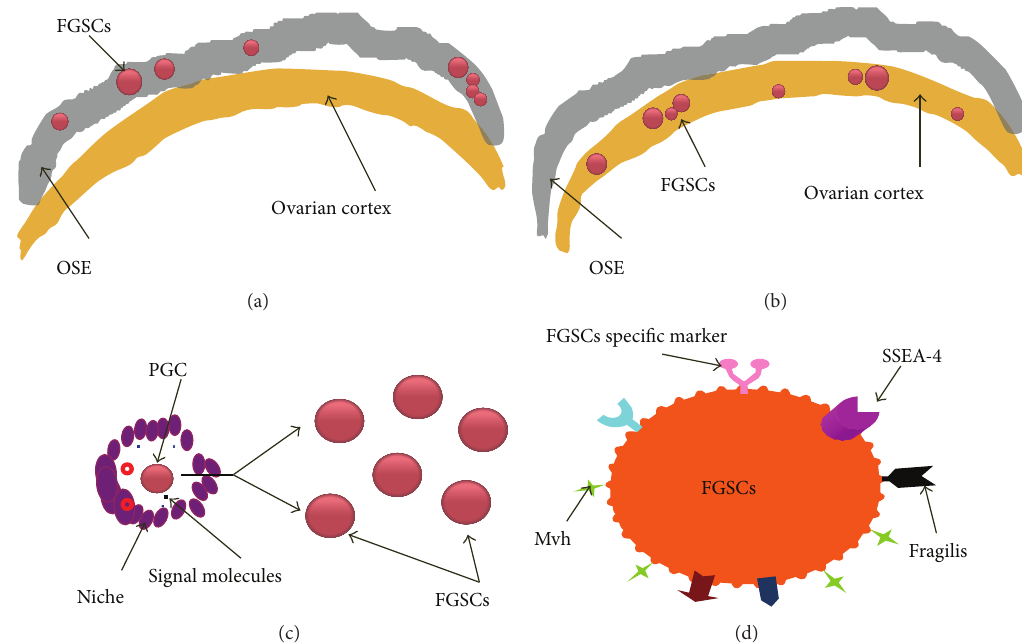
Figure 2: The existing challenge of putative FGSCs. ((a) and (b)) The putative FGSCs exact positioning in OSE or ovarian cortex. (c) The “niche” signals regulate PGC to differentiate into putative FGSCs. (d) Is there a putative FGSCs specific marker in cell